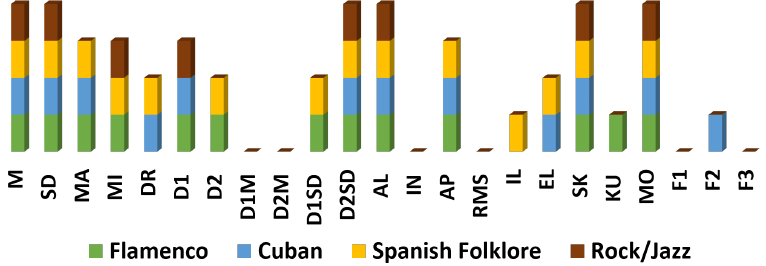
Figure 4. Statistically significant features for each of the musical genres according to their p